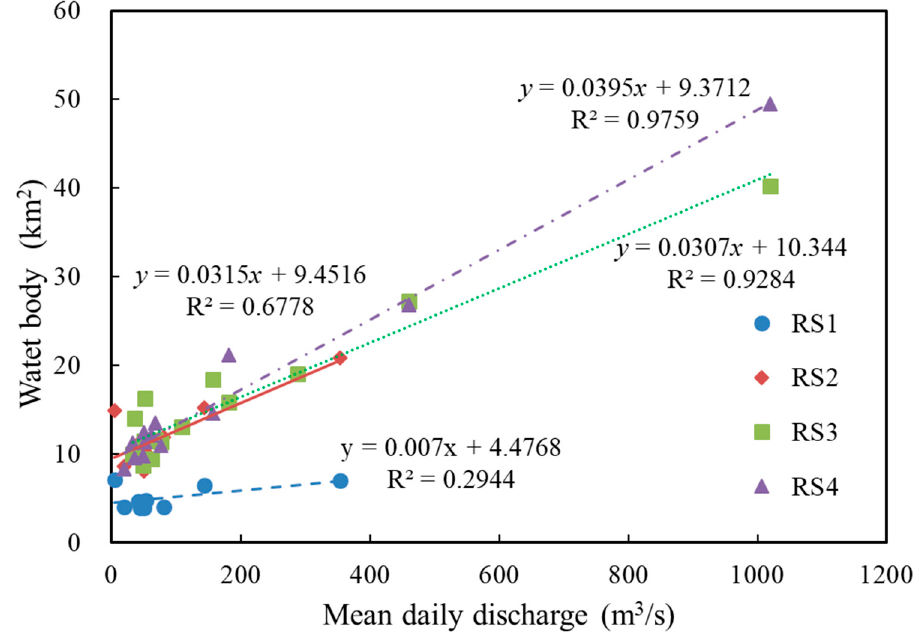
Figure 6. Relation between the mean daily discharge for each year from 2001 to 2016 at the Lhasa station and the area of surface water.